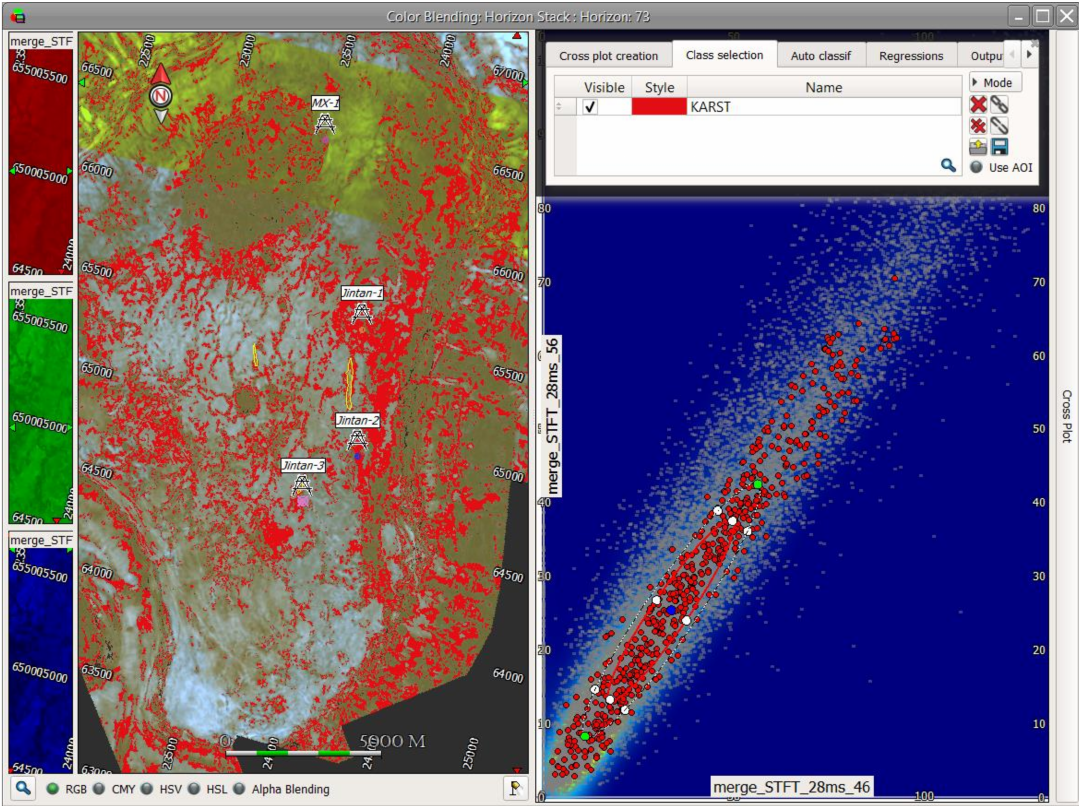
Figure 9. Karst geobody extraction module done in PaleoScan TM software before manual filtration and QC were